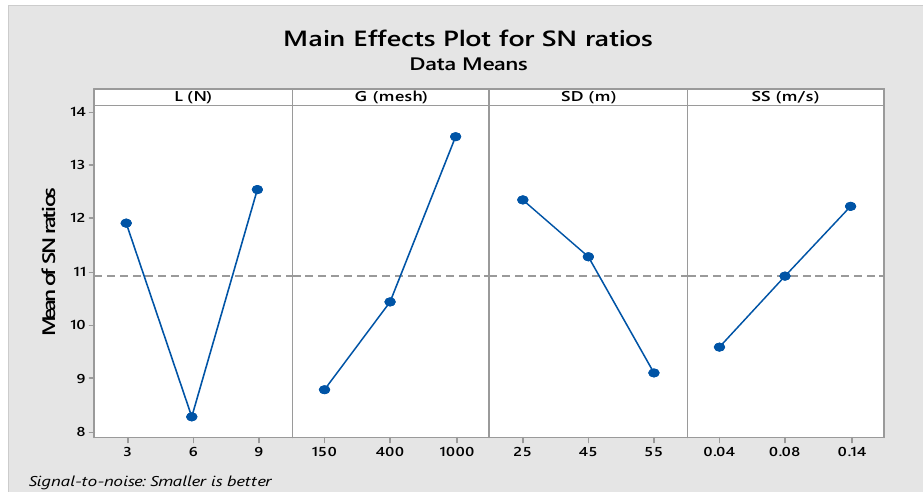
Figure 12. Main effect plot for SNRs of V L .